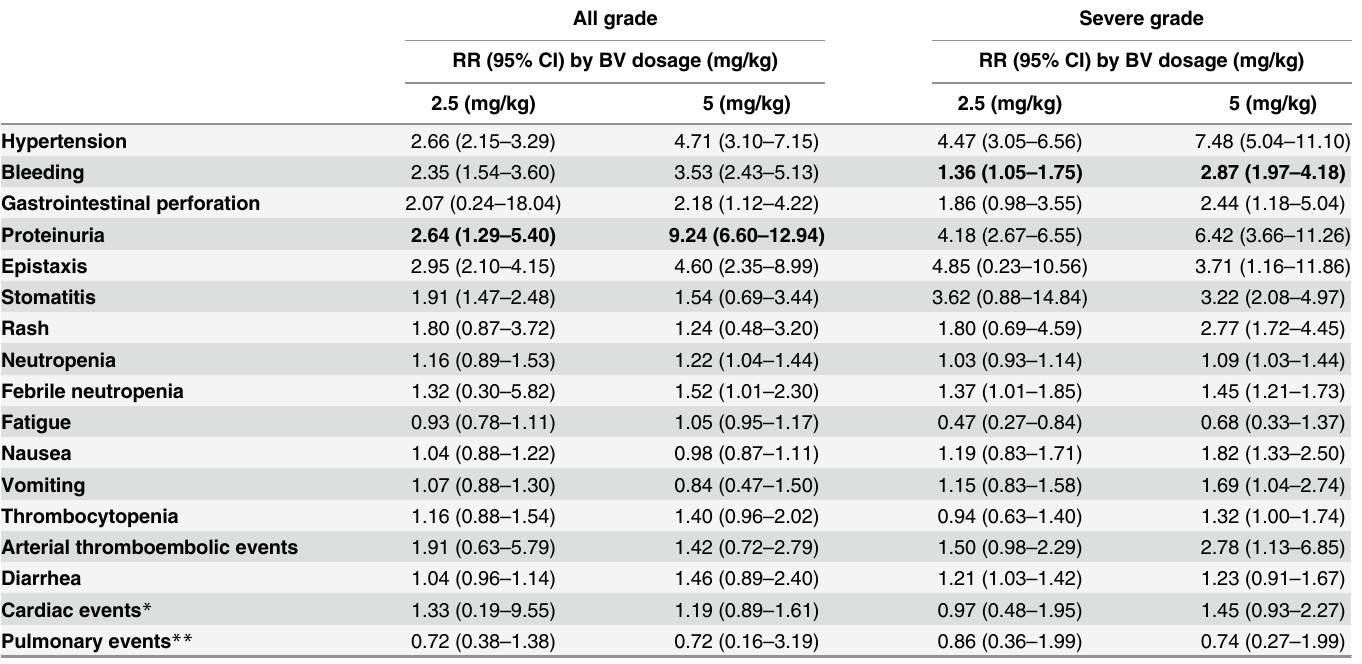
Table 7. Safety subgroup analyses in all trials